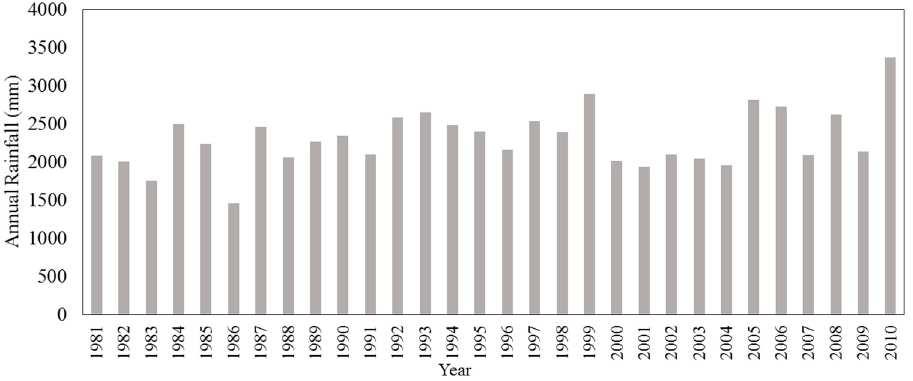
Figure 2. Annual average rainfall for Colombo for 30 years (1981–2010).